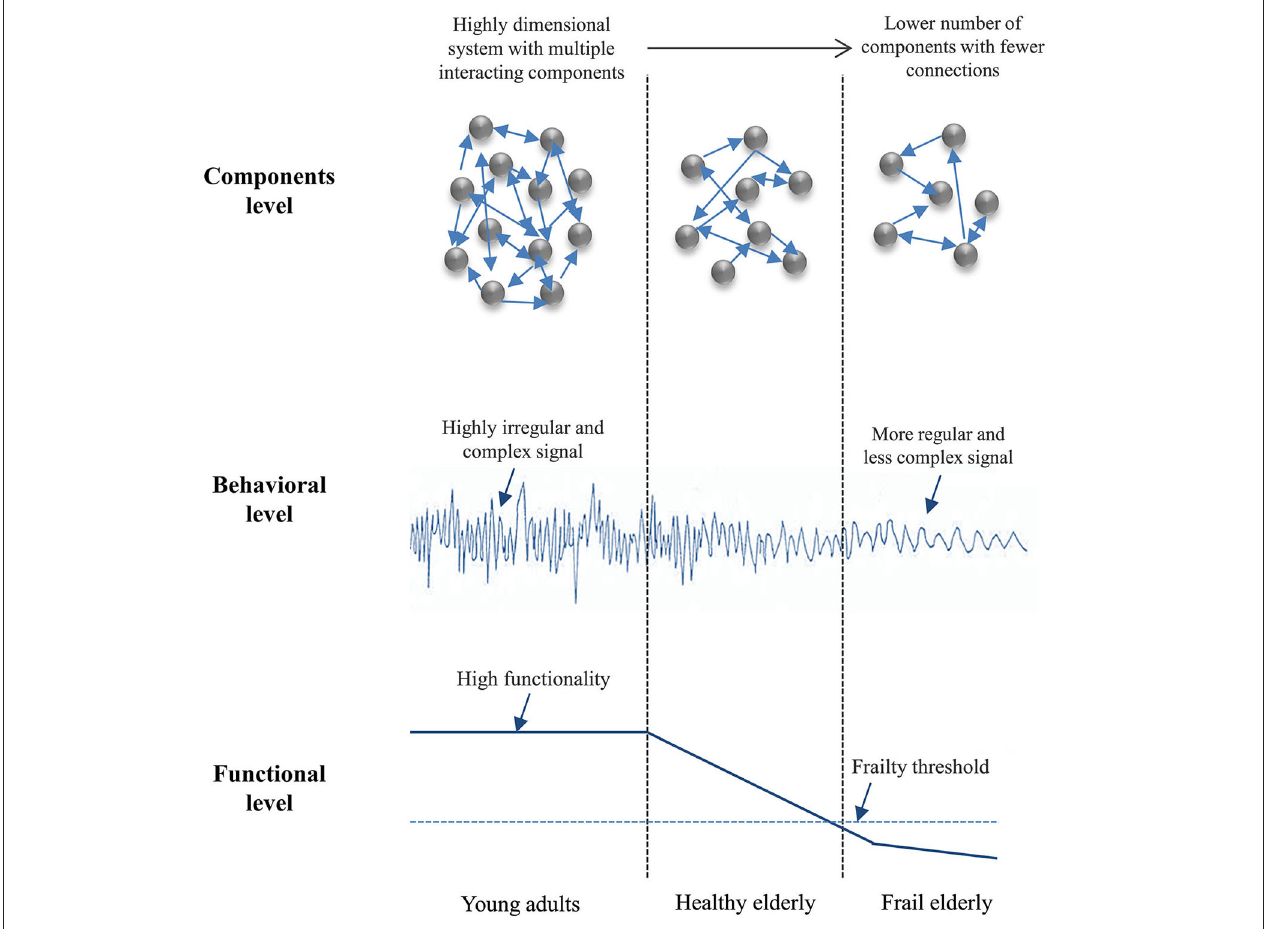
components and the complexity of their interactions drop down, behavior becomes increasingly predictable and the organism loses its functionality (e.g., in elderly). The frailty threshold represents the critical level of function below which the organism can no longer adapt to